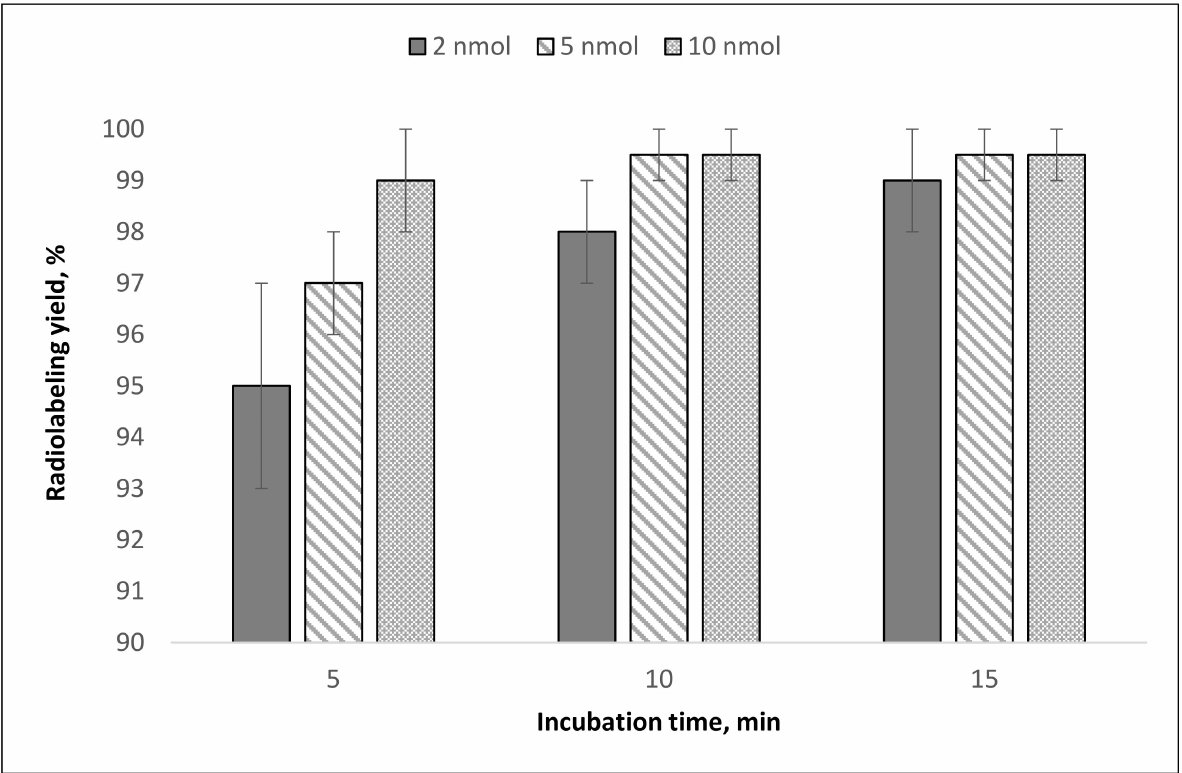
Figure 6. 44 Sc radiolabeling yields (mean ± SD, %; n = 7) for PSMA-617 at different precursor amounts and reaction times. Experimental conditions: convection heating 95 ◦ C, V = 1.0 mL, pH =